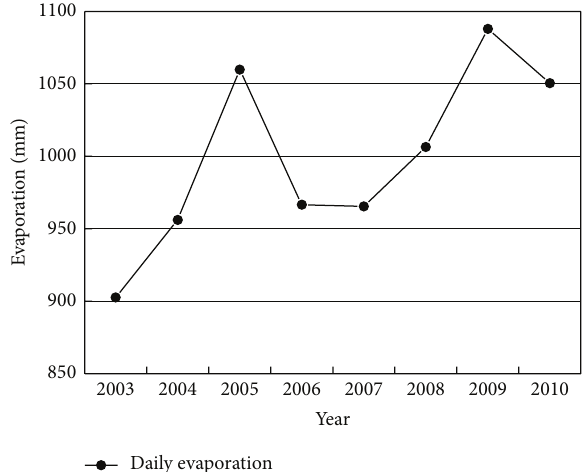
Figure 3: Variation trends of total annual daily evaporation in Dongping Lake from 2003 to